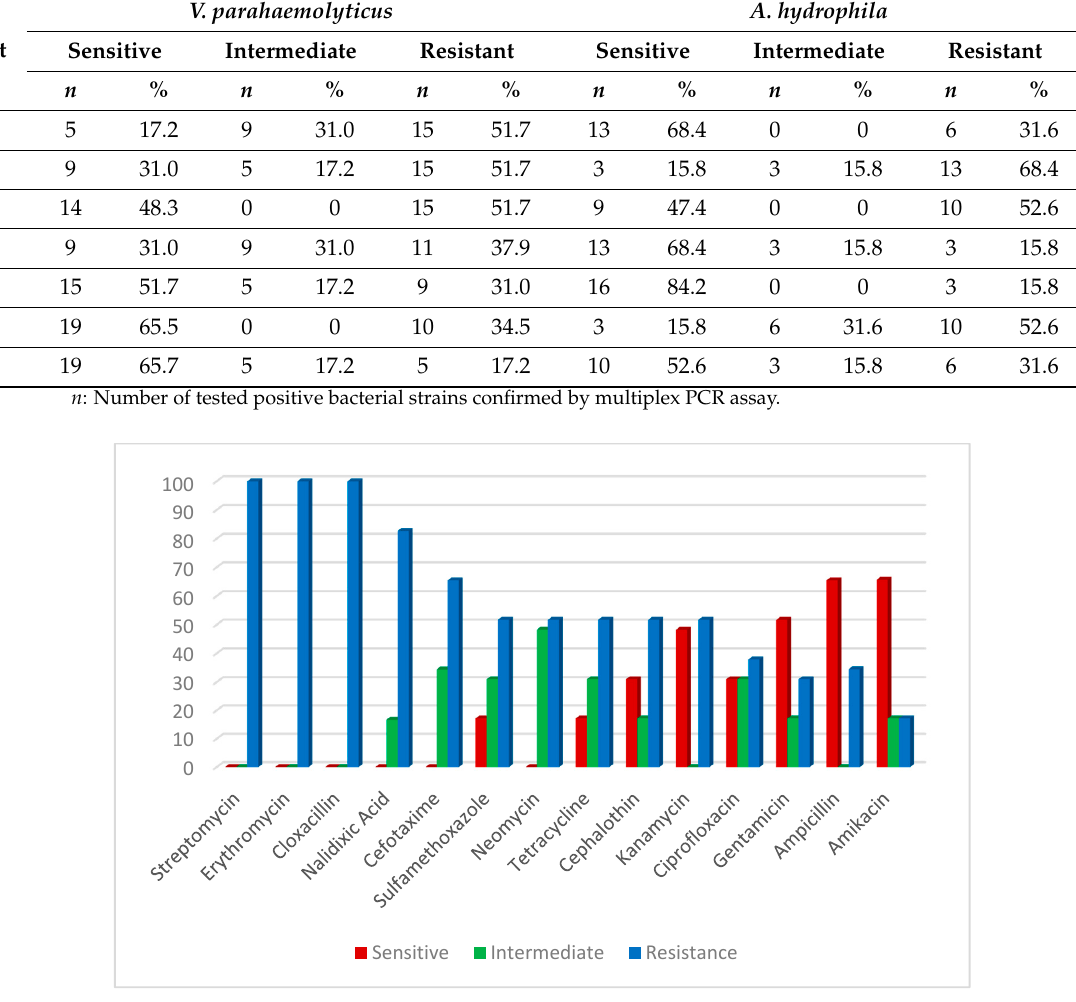
Figure 5. Antibiotic susceptibility of V. parahaemolyticus .